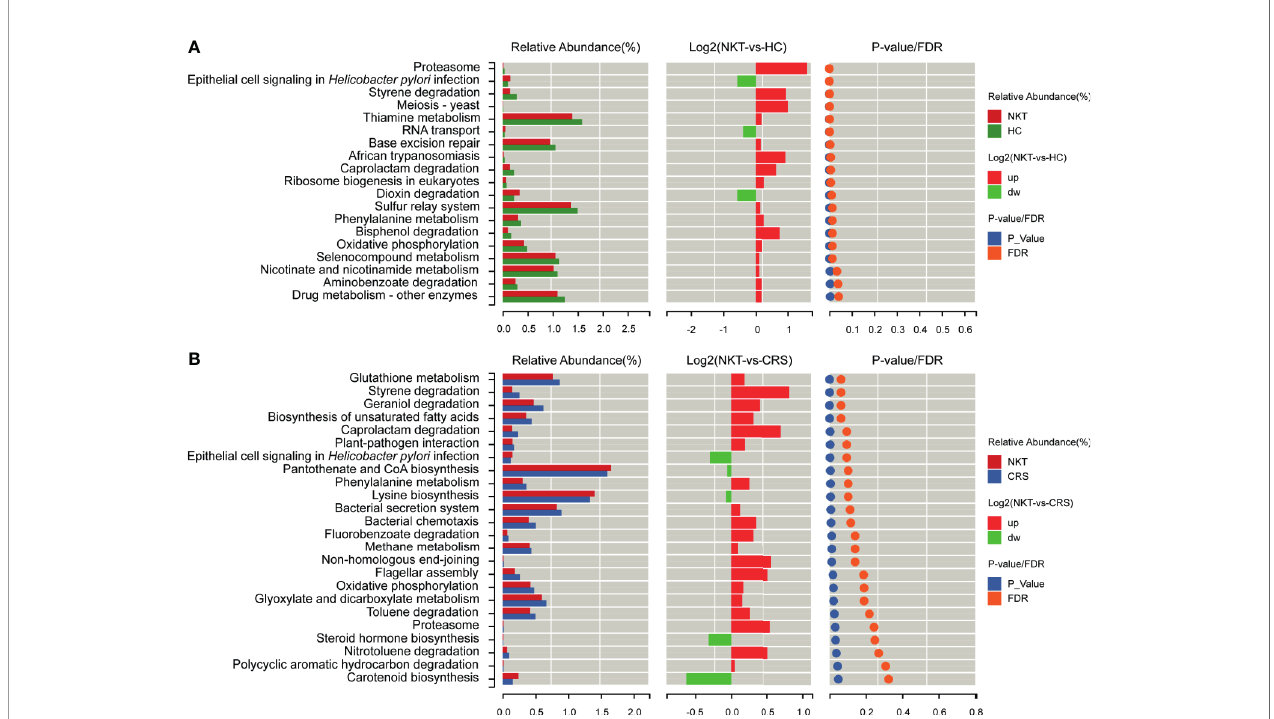
FIGURE 6 | Functional prediction of microbial genes associated with NKTCL by PICRUSt. (A) Compared with those in HCs, based on LDA selection, 3 predicted microbial functions, including epithelial cell signaling in Helicobacter pylori infection, RNA transport and dioxin degradation, were enriched, while 16 functions, including proteasome, styrene degradation and meiosis-yeast, were reduced in NKTCL patients. (B) Compared with those in CRS, 5 predicted microbial functions, including epithelial cell signaling in Helicobacter pylori infection, pantothenate and CoA biosynthesis and lysine biosynthesis increased, whereas 19 functions, including glutathione metabolism, styrene degradation and geraniol degradation decreased in NKTCL, but no signi fi cantly different function was found after FDR adjustment. NKT, natural killer/T cell lymphoma; CRS, chronic rhinosinusitis; HC, healthy control; PICRUSt, Phylogenetic Investigation of Communities by Reconstruction of Unobserved States; LDA, linear discriminant analysis; FDR, false discovery